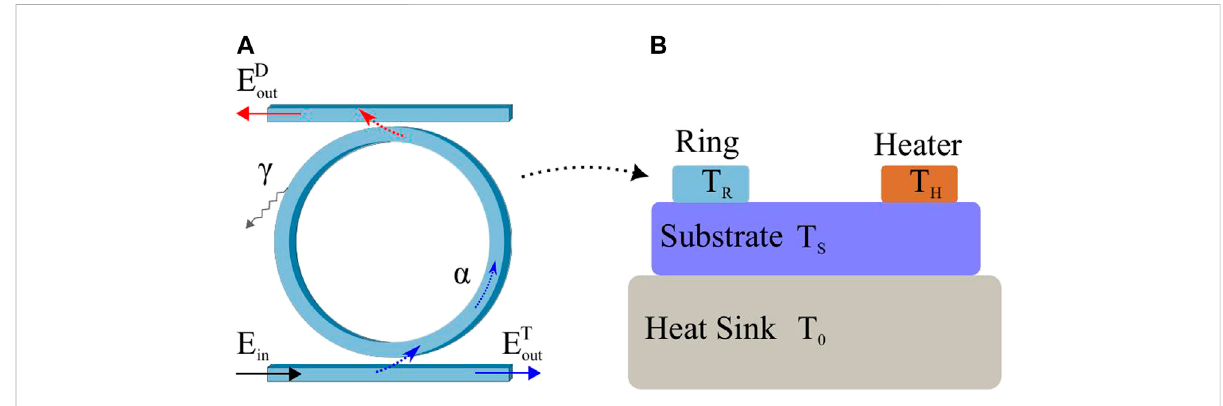
FIGURE 1 (A) Sketch of a microresonator in the add and drop con fi guration. (B) Sketch of the four blocks used to model the heat exchange between the microheater and the microresonator. The different symbols are de fi ned in the